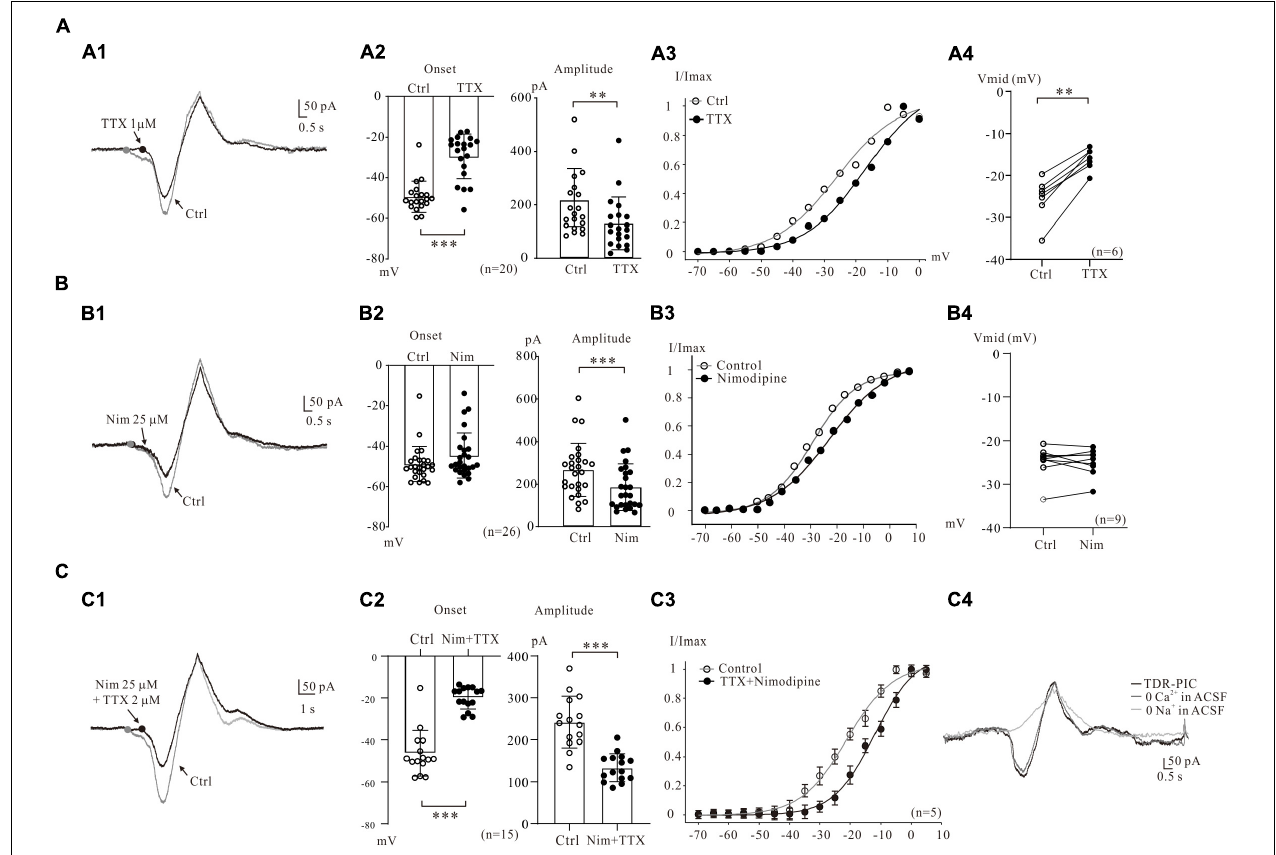
FIGURE 2 | Multiple components of PICs. (A) Na_PIC was differentiated from PICs. (A1) Overlapped current traces recorded by voltage ramps in control (gray) and application of 2 µ M TTX (black). (A2) Summary diagrams show the onset and amplitude of PICs recorded in control and presence of 1–2 µ M TTX ( n = 20). (A3) The half-maximal activations (V mid ) of the PICs were calculated as − 27.1 mV for control (open circles, A2 ) and − 14.3 mV for TTX. (A4) Summary diagrams show the V mid of PICs recorded in control and presence of 1–2 µ M TTX ( n = 6). (B) Ca_PIC was differentiated from PICs. (B1) Overlapped current traces recorded by voltage ramps in control (gray) and application of 25 µ M Nimodipine (black). (B2) Summary diagrams show the onset and amplitude of PICs recorded in control and presence of 25 µ M Nimodipine ( n = 26). (B3) The V mid were calculated as − 27.9 mV for control (open circles) and − 25.7 mV for Nimodipine. (B4) Summary diagrams show the V mid of PICs recorded in control and presence of 25 µ M Nimodipine ( n = 9). (C) TDR_PIC was differentiated from PICs. (C1) Overlapped current traces recorded by voltage ramps in control (gray) and application of 1 µ M TTX and 25 µ M Nimodipine (black). (C2) Summary diagrams show the onset and amplitude of PICs recorded in control and presence of 1–2 µ M TTX and 25 µ M Nimodipine ( n = 15). (C3) Results from five neurons, the V mid were calculated for PICs (open circles) and TDR_PIC ( n = 5). (C4) TDR_PIC was not changed after the calcium was removed from recording artificial cerebrospinal fluid (ACSF), but was completely blocked after complete removal of sodium from the recording solution. Error bars show SD. ∗∗ P < 0.01, ∗∗∗ P < 0.001, paired t